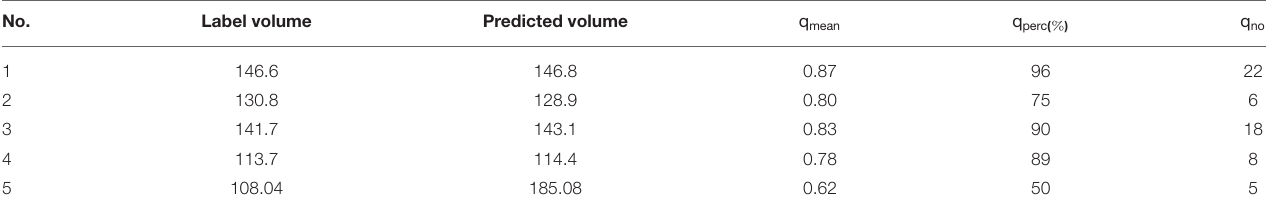
FIGURE 8 | The top row shows (A) the regression plot and (B) the kernel density estimate plot along the two variables (label volume and predicted volume) marginal distributions. It also shows (C) the regression plot along the two variables’ boxplots and (D) the kernel density estimate and histogram plots of the variables with the dashed vertical lines representing the arithmetic mean of the distributions. The symbols ρ and p represent the p-value and Pearson correlation coefficient, respectively. The plots (A–D) correspond to the label volumes vs. the predicted volumes without quality control (QC) and the plots (E–H) correspond to these variables using the proposed QC framework.